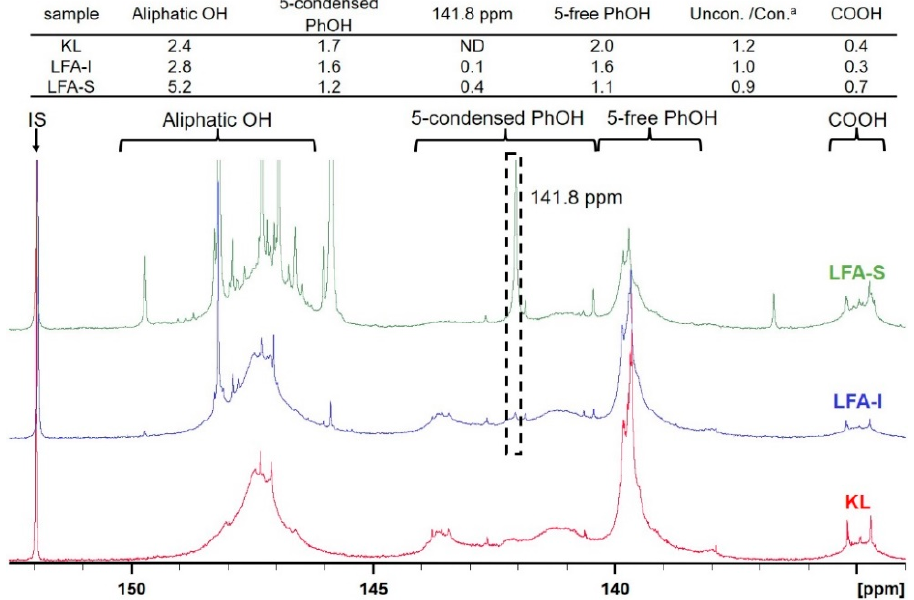
Figure 6. 31 P NMR spectra of the original KL and LFA bioresin fractions and the calculated values (mmol/g). a Uncon./Con. is the ratio between the amount of 5 ‐ free PhOH and 5 ‐ condensed PhOH.